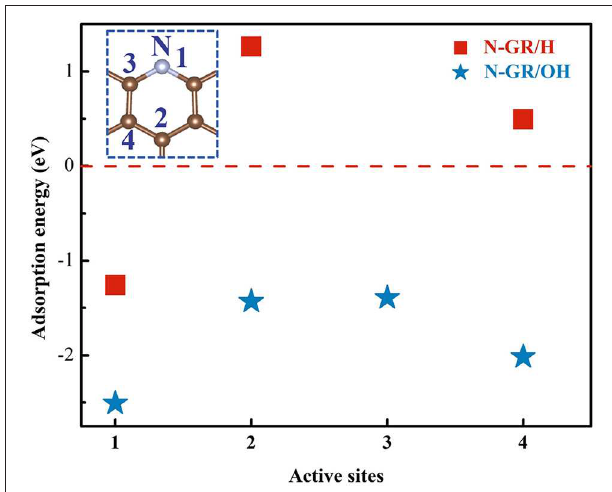
FIGURE 2 | The adsorption energy of E ad − H and E ad − OH at different sites, which is shown as the inset on the